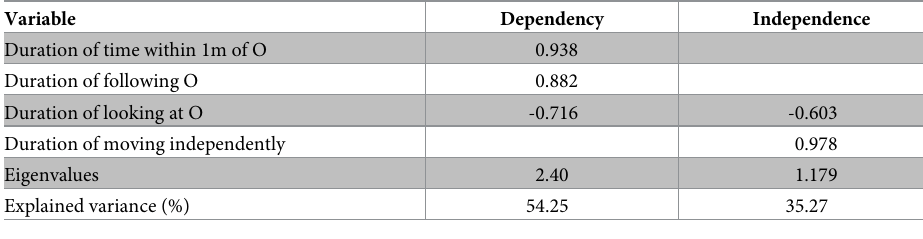
Table 5. Components derived from PCA on the variables measured in the picture viewing subtest.